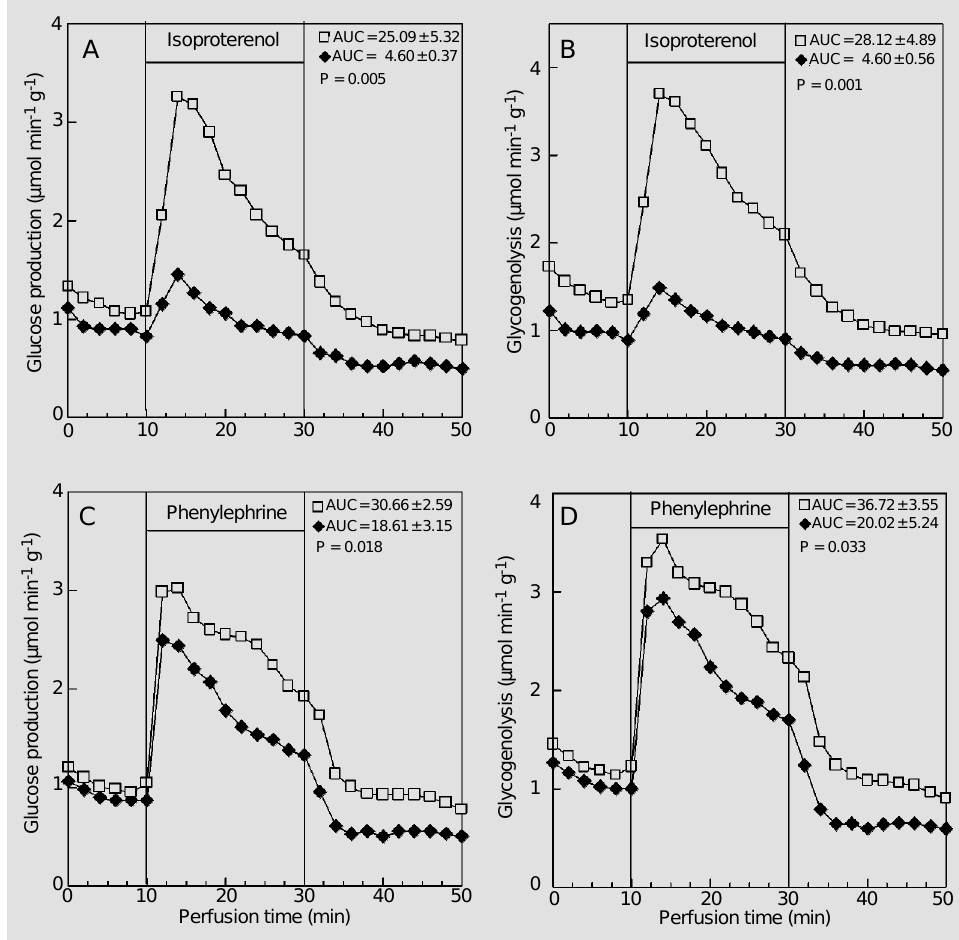
Figure 2 - Effect of isoproterenol (20 µM; panels A and B) and phenylephrine (2 µM; panels C and D) on glucose production and glycogenolysis. The data re- ported are the mean of at least 5 individual liver perfusion ex- periments performed 60 min after injection of saline (CN group, squares) or insulin (IN group, diamonds). The livers were perfused as described in Material and Methods. AUC = Area under the curve. The sta- tistical test used was the un- paired Student